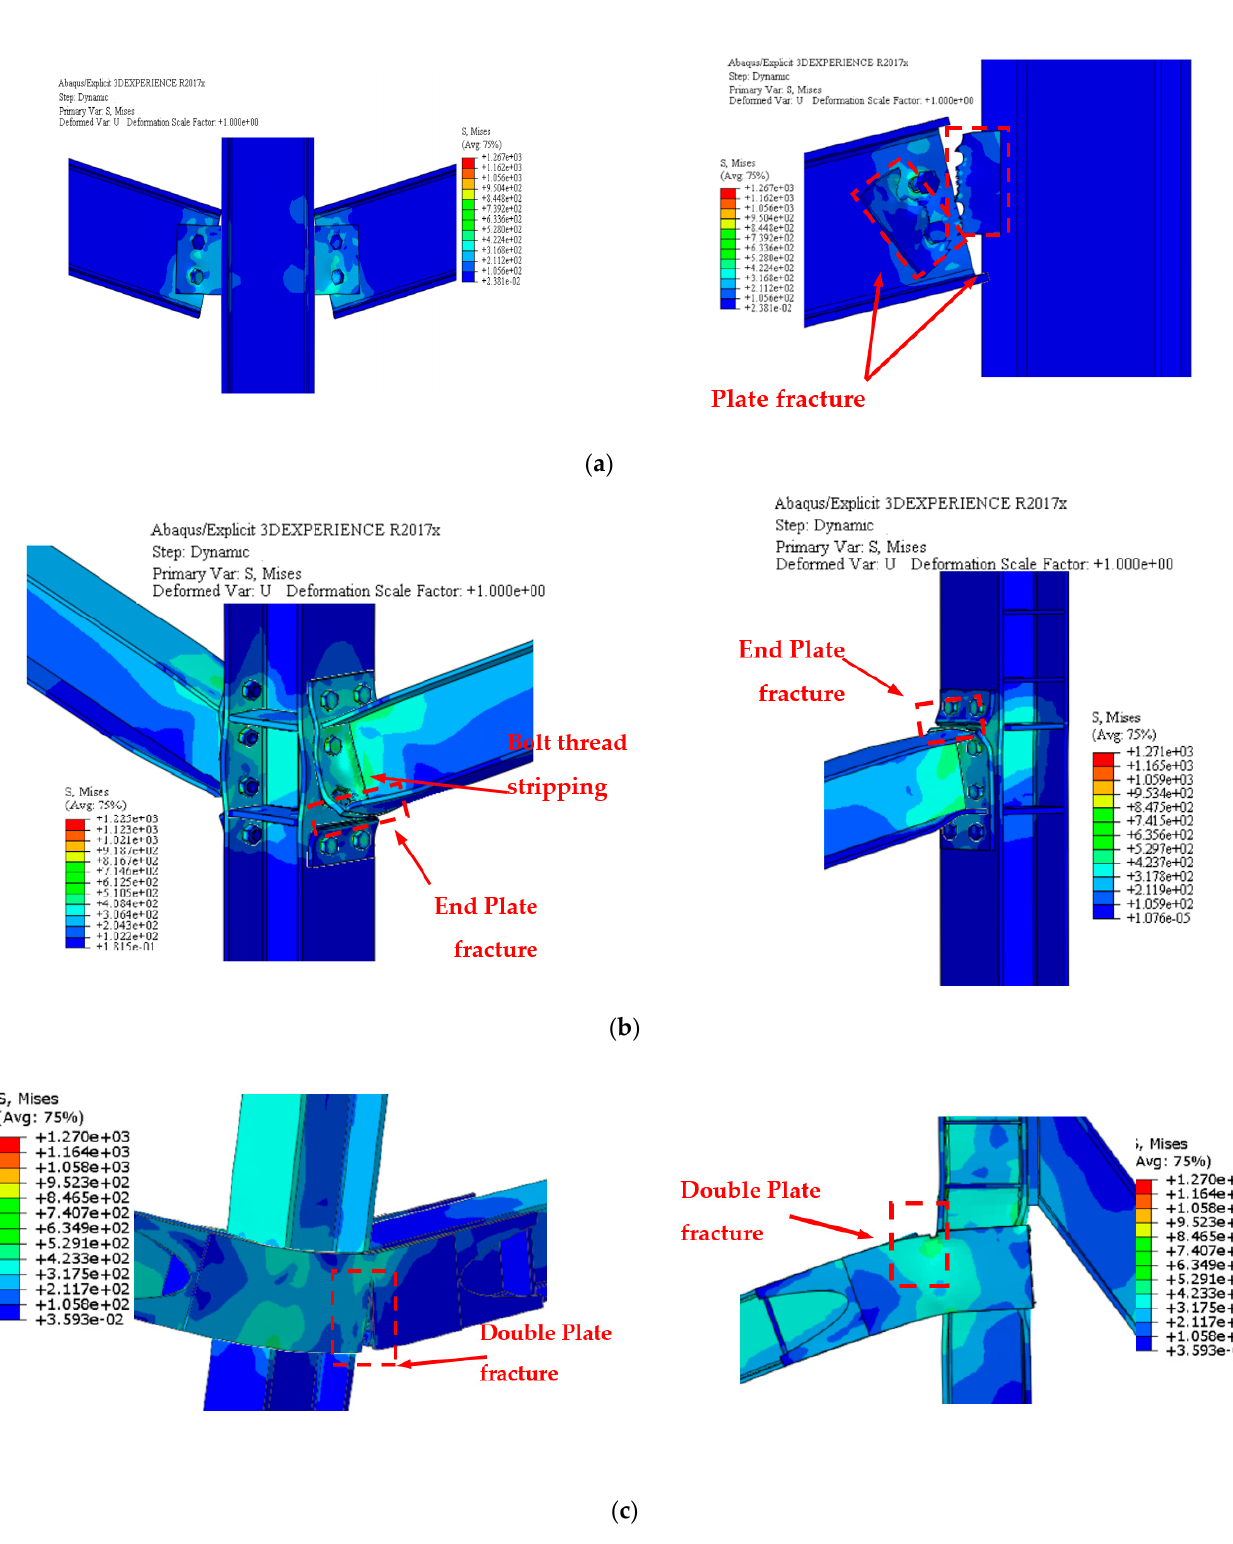
Figure 10. Failure-mode for FE mode testes (external and middle joint): ( a ) J-S-C joint; ( b ) J-M-C joint; ( c ) J-S-S-EX joint.